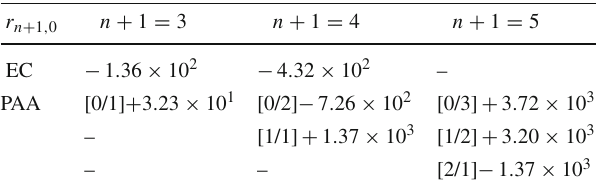
Table 3 Comparison of the exact (“EC”) ( n + 1 ) th-order conformal coefficients with the predicted (“ [ N / M ] -type PAA”) ( n + 1 ) th -order ones based on the known n th-order approximate ˆ R n ( M H ) , where n = 2 , 3 , 4, respectively